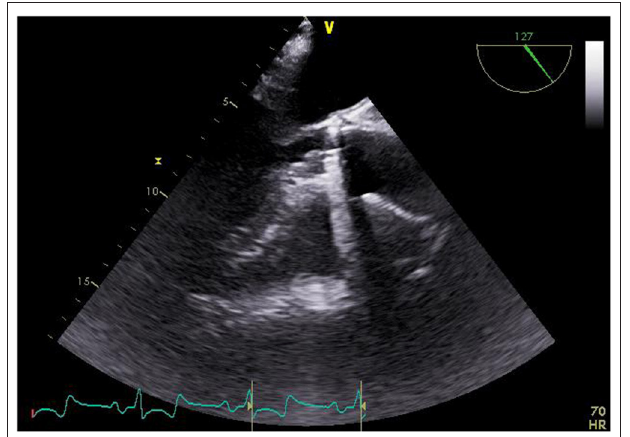
FIGURE 1 | Echocardiographic finding of the vegetation at the annulus of the implanted valve prosthesis.